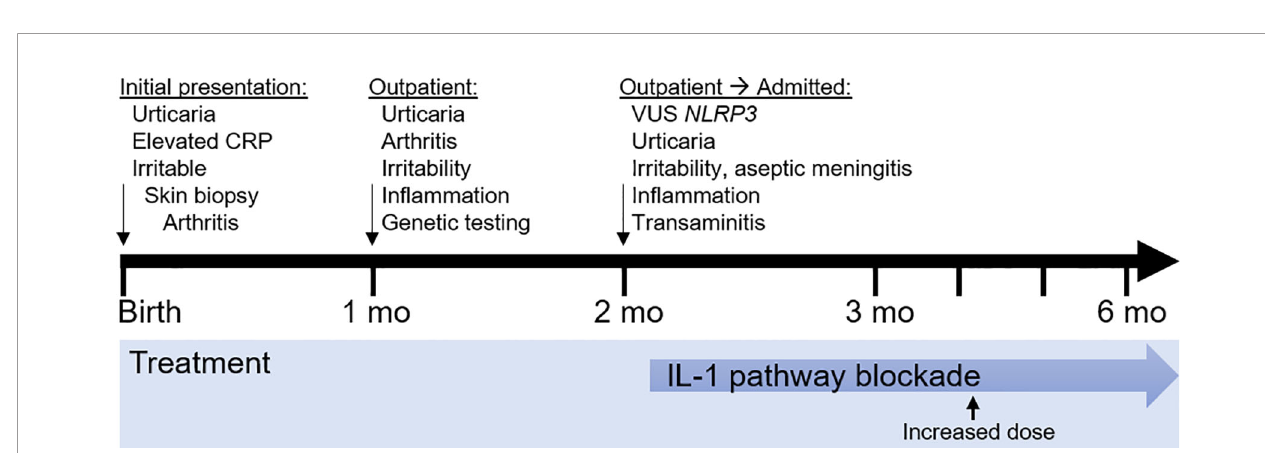
FIGURE 2 | Timeline of clinical events and treatment strategies. mo, month.